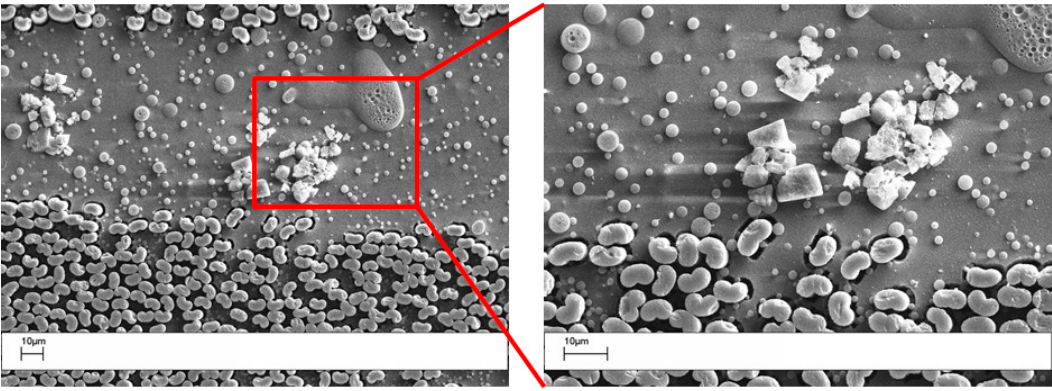
Figure 9. SEM of the interlaminar region for the composites with dissolved in 10 wt % of coPES/1% POSS. On the right is the magnification (1000×) view of a POSS micro agglomerate. A higher resolution SEM coupled with EDX analysis was performed on the same sample. The analysis at a magnification of 80,000× revealed the presence of nanoscaled POSS crystallites (Figure 10). respectively, by uniform resin morphology (Figure 11, zone 1), coPES spherical particles (zone 2), and showed the presence of Si and Cl in zone 3, which is clearly characterized by the presence of POSS agglomerates. The EDX analysis of zone 1 and 2 did not show clearly the presence of Si and Cl, but due to the resolution of the EDX, this result cannot be used to assess the presence or absence of POSS at the nanoscale. In zone 2, above the micrometer sphere, the EDX analysis revealed the presence of S, which is coming from the coPES polymer. The presence of a rich S area confirms that the spherical particles are coPES